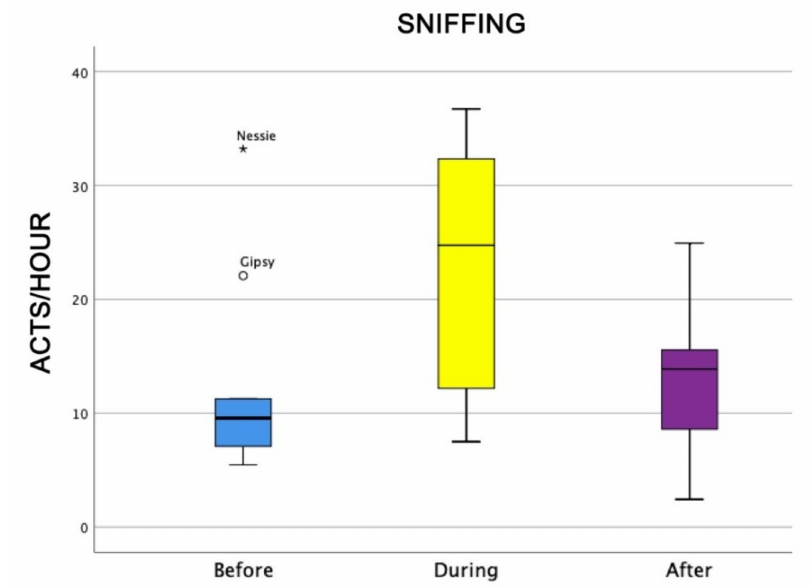
Figure 8. Behavioural patterns related to dogs’ level of sni ffi ng before, during, and after AAI sessions. Non-parametric data are represented as medians (horizontal bar in the box) and the box indicates the interquartile range of 50% of the data. Whiskers extend to the smallest and largest values and exclude outliers (dot on